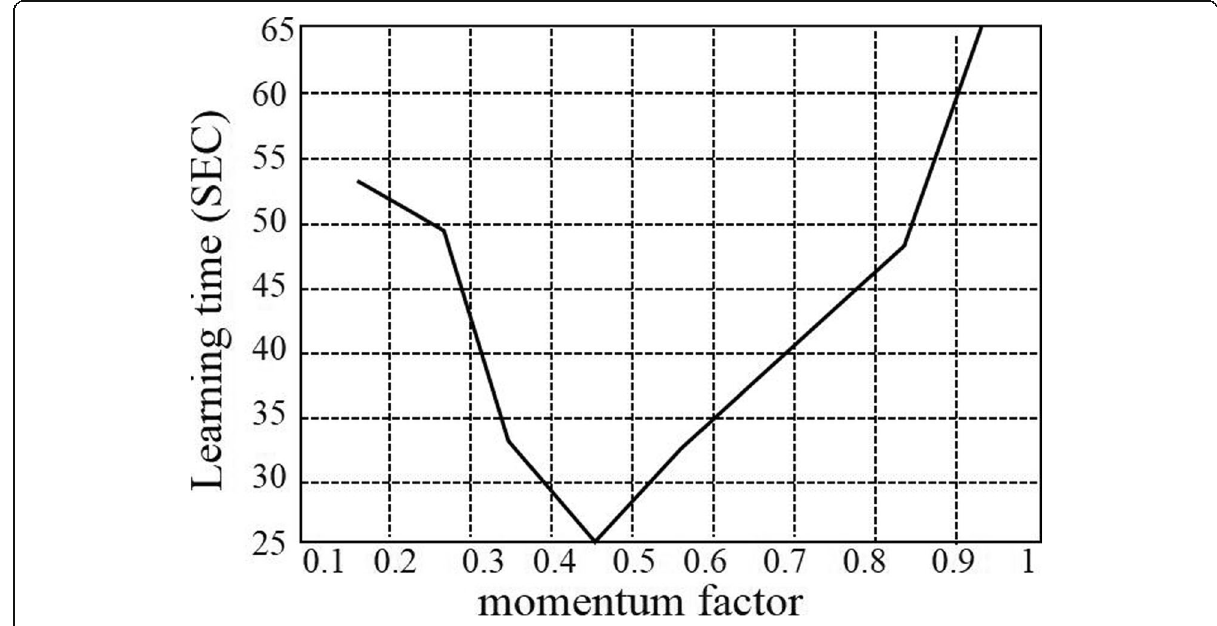
Fig. 4 Change chart of learning time with momentum